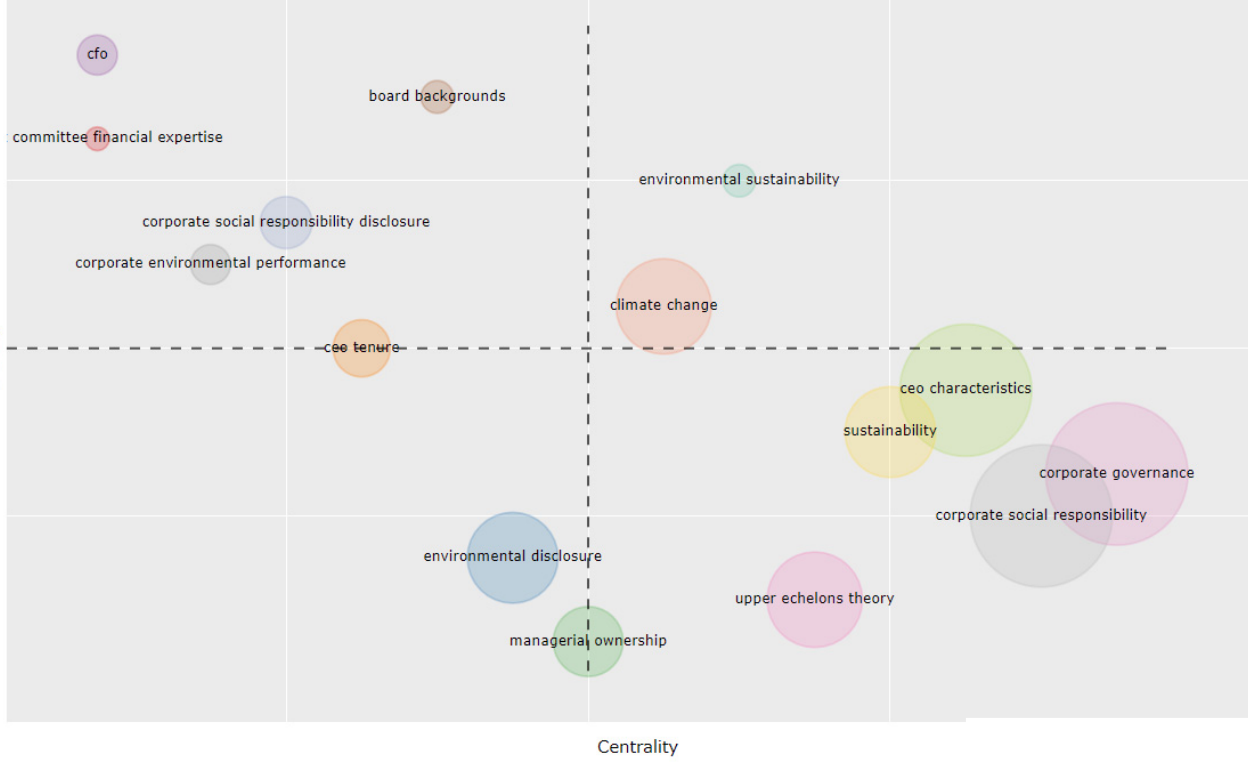
Figure 8. Thematic Map.